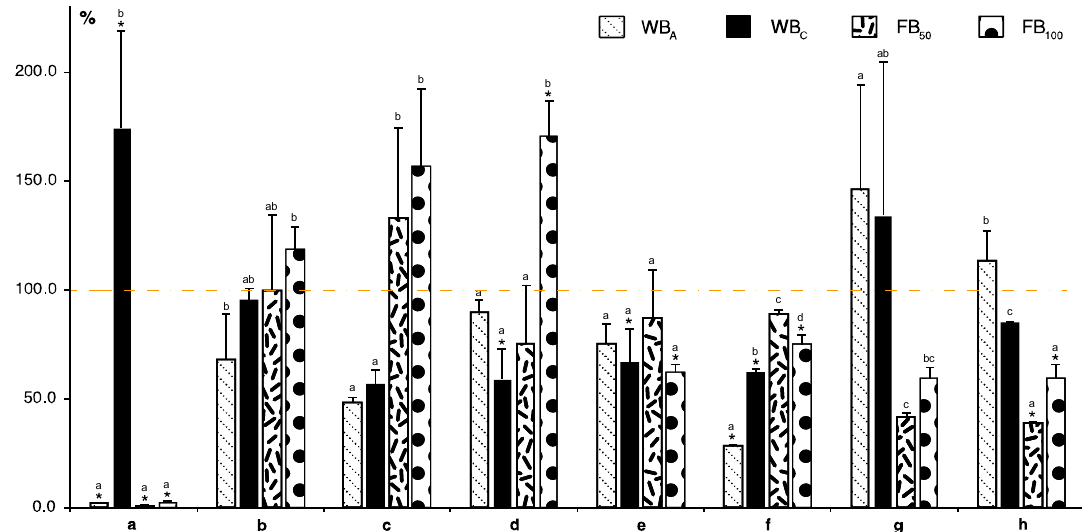
Figure 4. Effect of insect treatment on phenolic acids content in white cabbage. ( a ) t -cinnamic acid; ( b ) p -coumaric acid; ( c ) caffeic acid; ( d ) ferulic acid; ( e ) chlorogenic acid; ( f ) benzoic acid; ( g ) salicylic acid; ( h ) 4-hydroxy benzoic acid. All bar values were recalculated relative to the compound content in untreated samples taken as 100%. Data are means of three repeats ± SE. The asterisk (*) represents a significant difference between treated samples and controls, and different letters between the values of one compound. p < 0.05 by Fisher’s least significant difference (LSD) test.